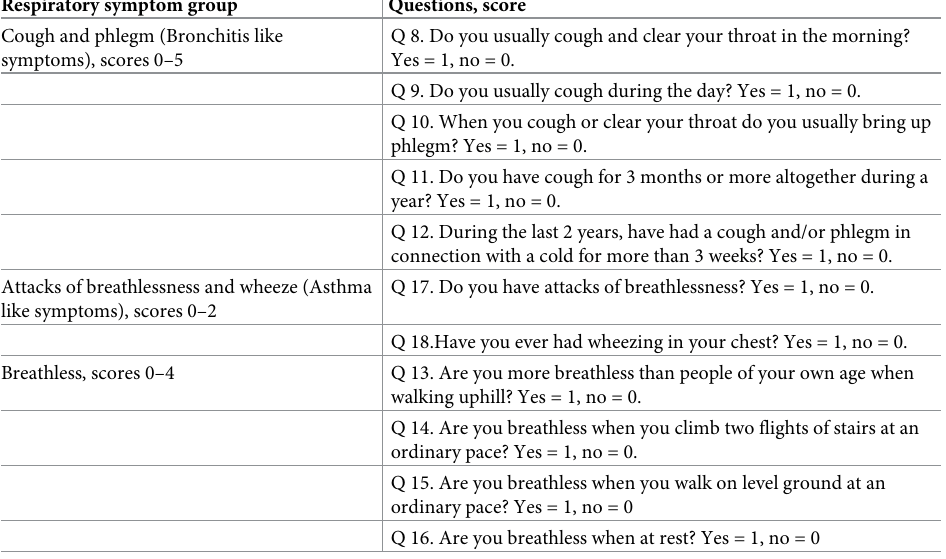
Table 2. Questions (Q) on respiratory symptoms and